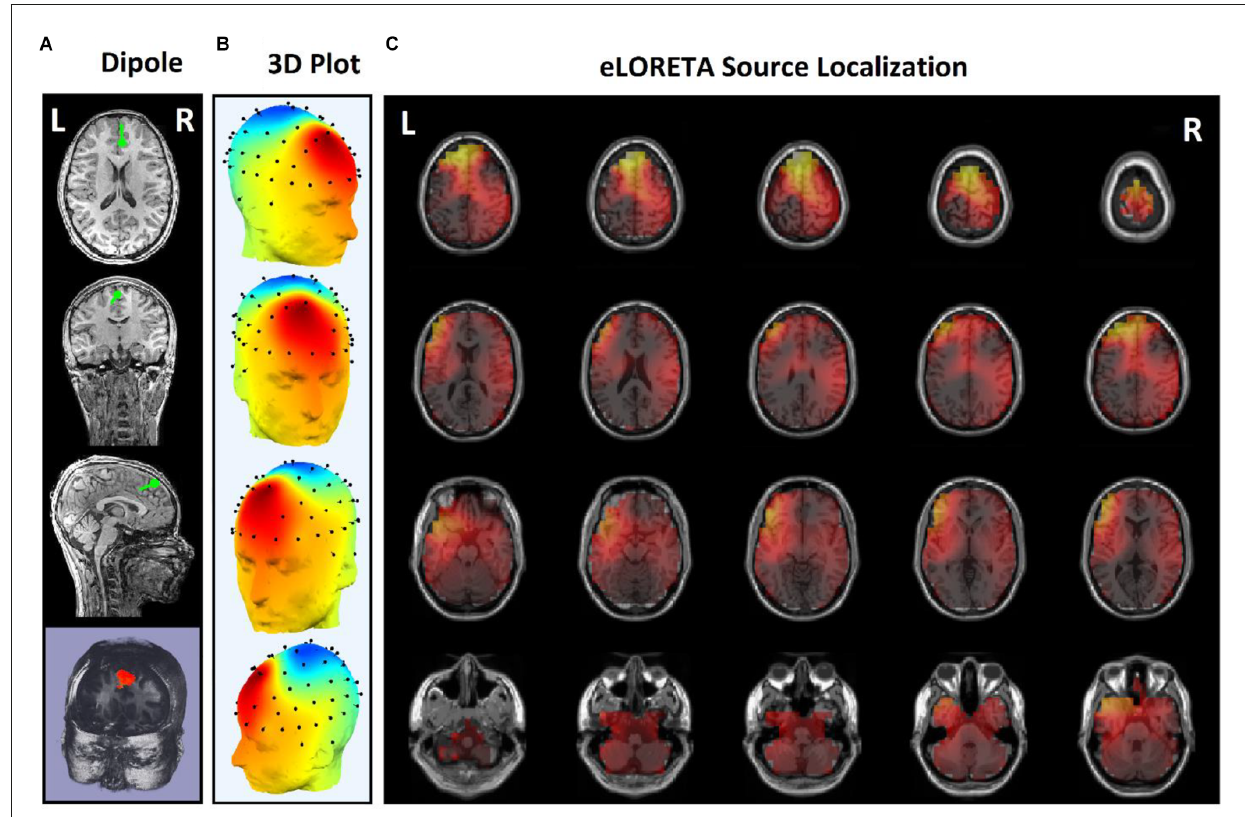
FIGURE8 Source localization of the rTMS stimulation foci in center of frontal for a responder subject. (A) Dipole coordinates of the identified focus in the center of frontal region on a default MRI. (B) Position of the foci identified by ICA on the surface of the skull. (C) Source localization in right DLPFC by eLORETA.